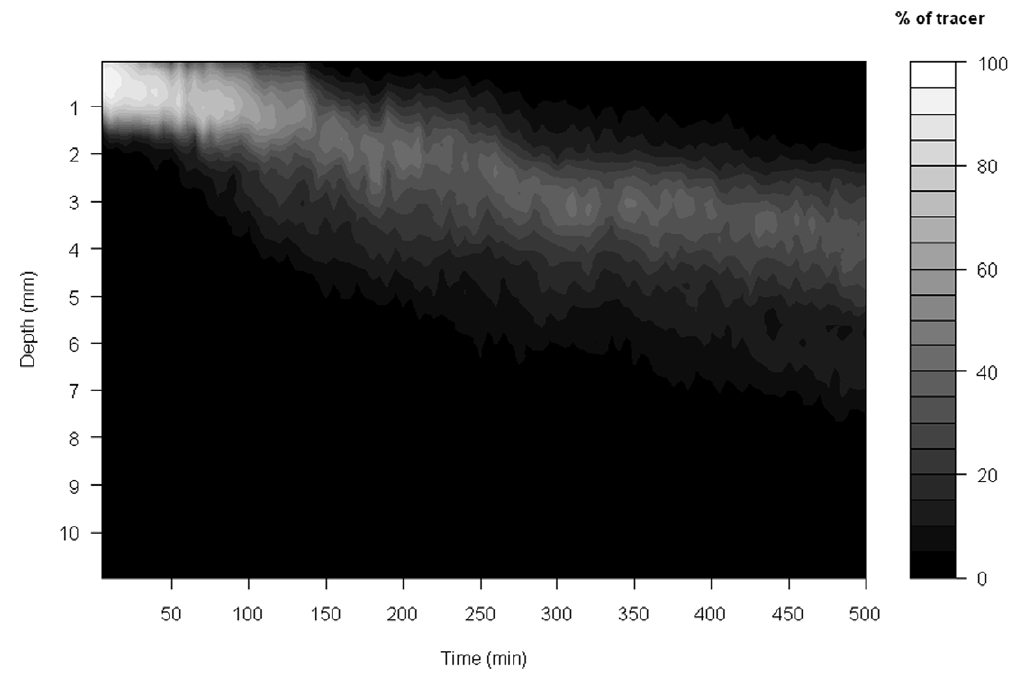
Figure 1. Visualisation of experimental data where grey shades denote the relative density of luminophores at a given depth (y- axis) and time point (x-axis).